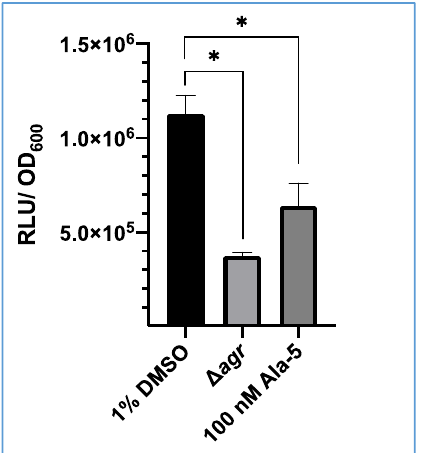
Figure 4. Impact of Ala 5 (AIP ‐ 1) on bioluminescence output from S. aureus USA300 agr P3 ‐ GLuc. The 1% v/v DMSO represents USA300 agr P3 GLuc with 1% DMSO, Δ agr represents USA300 Δ agr P3 ‐ GLuc and 100 nM Ala ‐ 5 represents USA300 agr P3 GLuc with addition of 100 nM (Ala 5 )AIP ‐ 1. The data shown are the means with error bars displaying standard deviation of triplicate technical repeats and is representative of biological triplicate repeats. * p < 0.01.